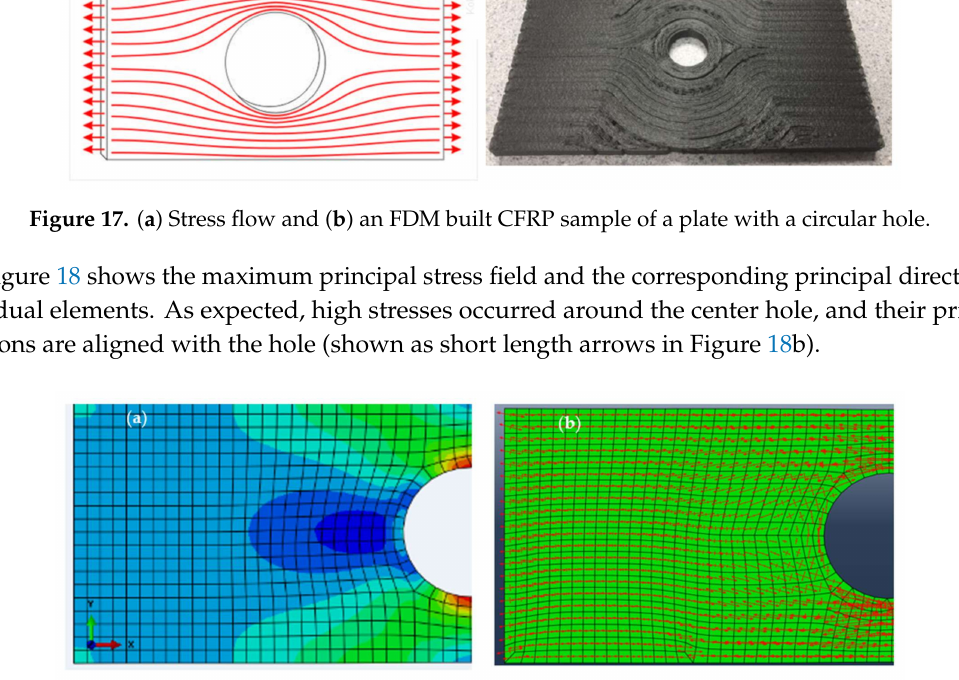
Figure 18. ( a ) maximum principal stress field and ( b ) principal directions of the plate with the circular hole under tensile loading.